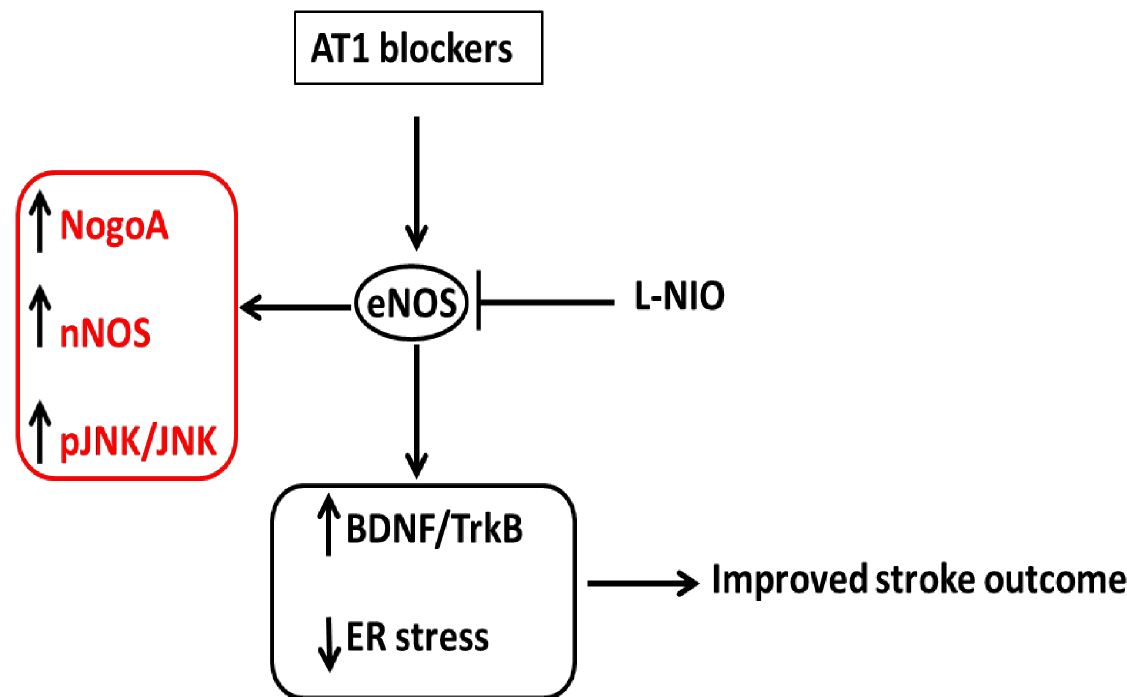
Fig 7. A schematic representation of the main findings. Acute administration of ARBs improvesshort term functionaloutcome through an eNOS mediated amelioration of ER stress and BDNF/TrkB mediated signaling. Acute eNOS inhibitionincreases NOGO-A, nNOS expressionand JNK